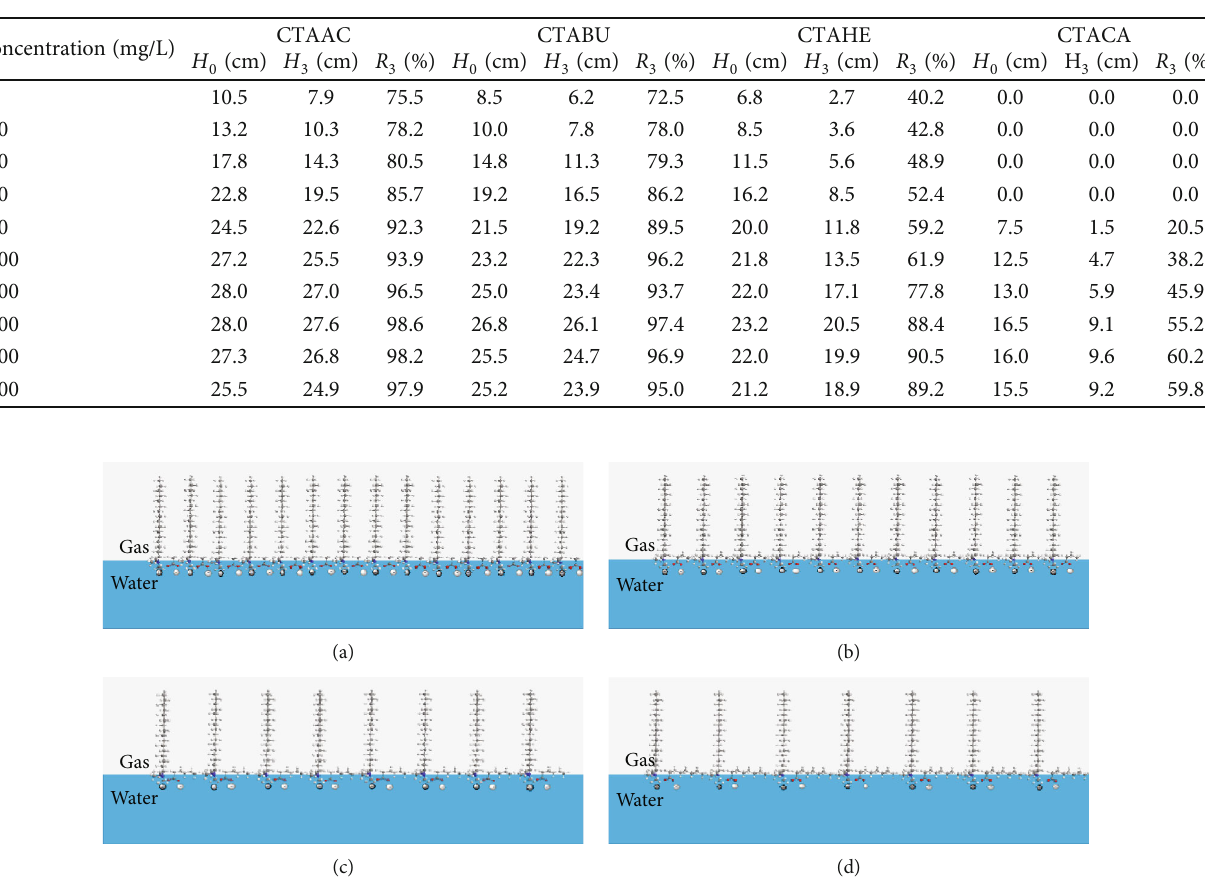
Table 4: Foaming properties of four surfactants with di ff erent concentrations at room temperature.